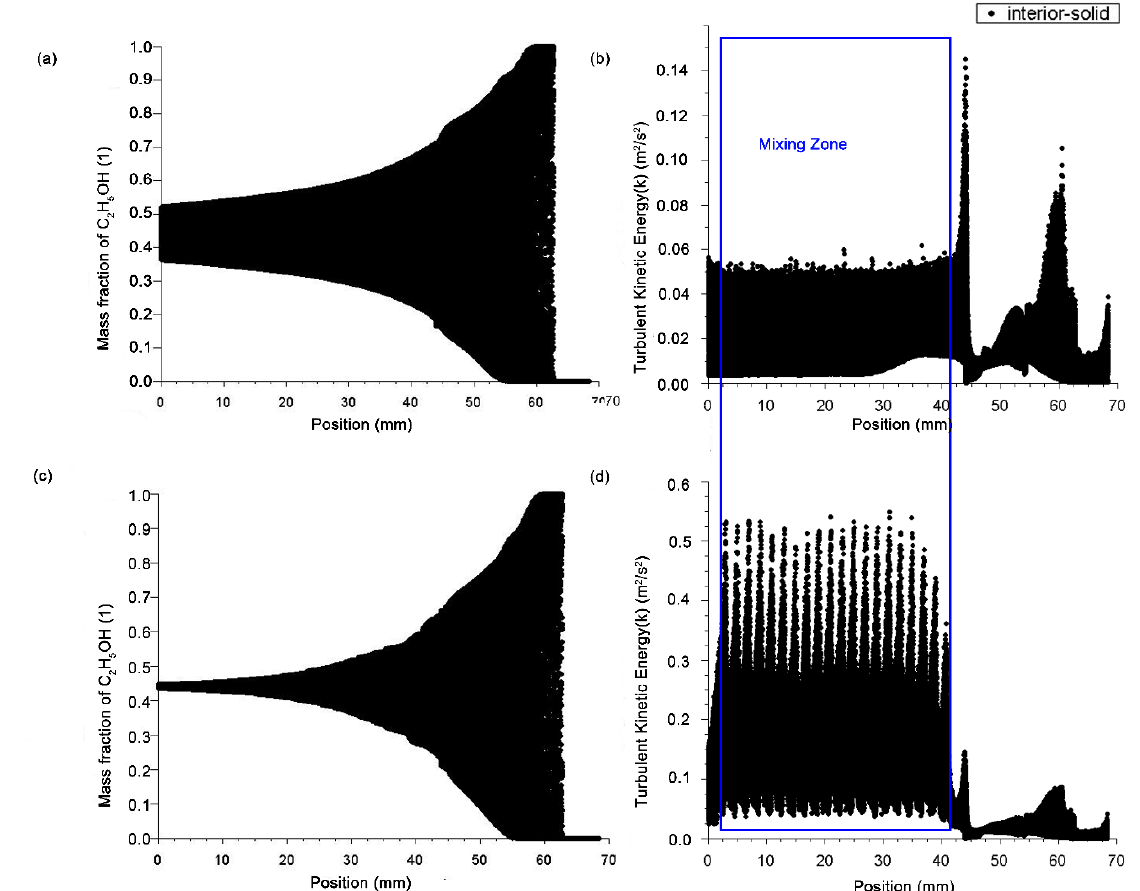
Figure 11. Comparison diagram of a variation of the mass fraction of the component and the turbulent kinetic energy along the axial direction: ( a ) mass fraction of the component chart without obstacles; ( b ) turbulent kinetic energy chart without obstacles; ( c ) mass fraction of the component chart with obstacles; ( d ) turbulent kinetic energy chart with